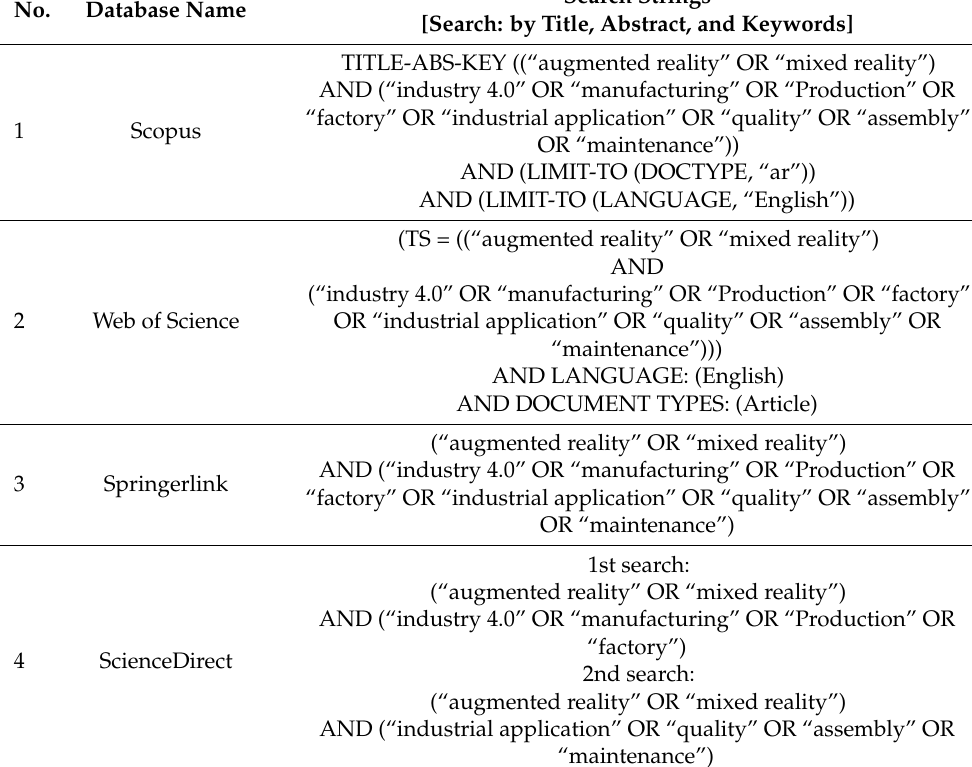
Table 2. Database query